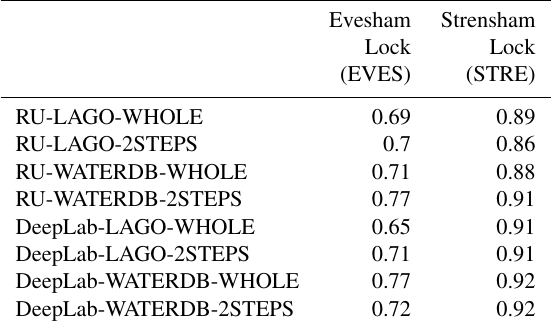
Table 5. Pearson’s Correlation Coefficients computed between the landmark-based water-level estimation and the water levels from the nearest river gauges on Evesham and Strensham Lock